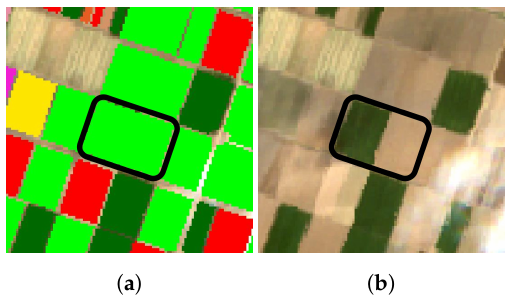
Figure 4. Visualization of an example of a suspected mis-split Cotton crop from the Sector BXII crop survey. ( a ) Superposition of Sentinel-2 RGB image of 22/04/17 and supplied crop types; ( b ) Sentinel-2 RGB image acquired the